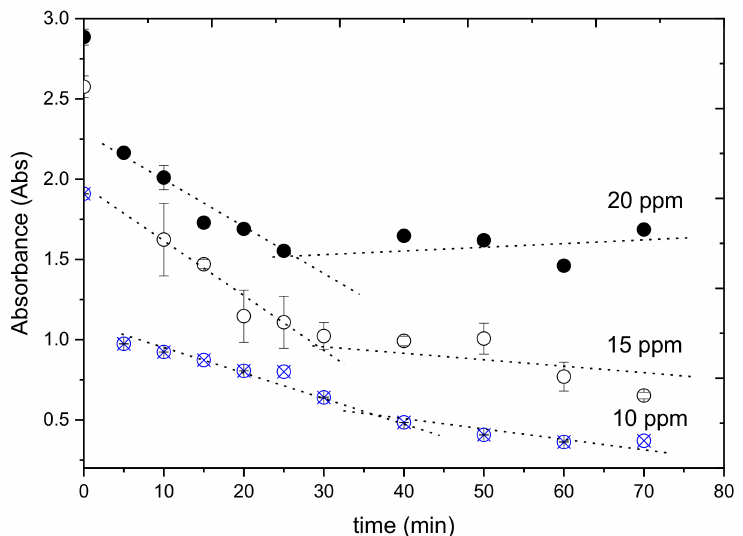
Figure 8. The adsorption curves at various time and three conditions of initial MB